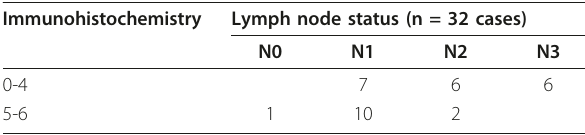
Table 3 Correlation between PKP3 expression and nodal metastasis